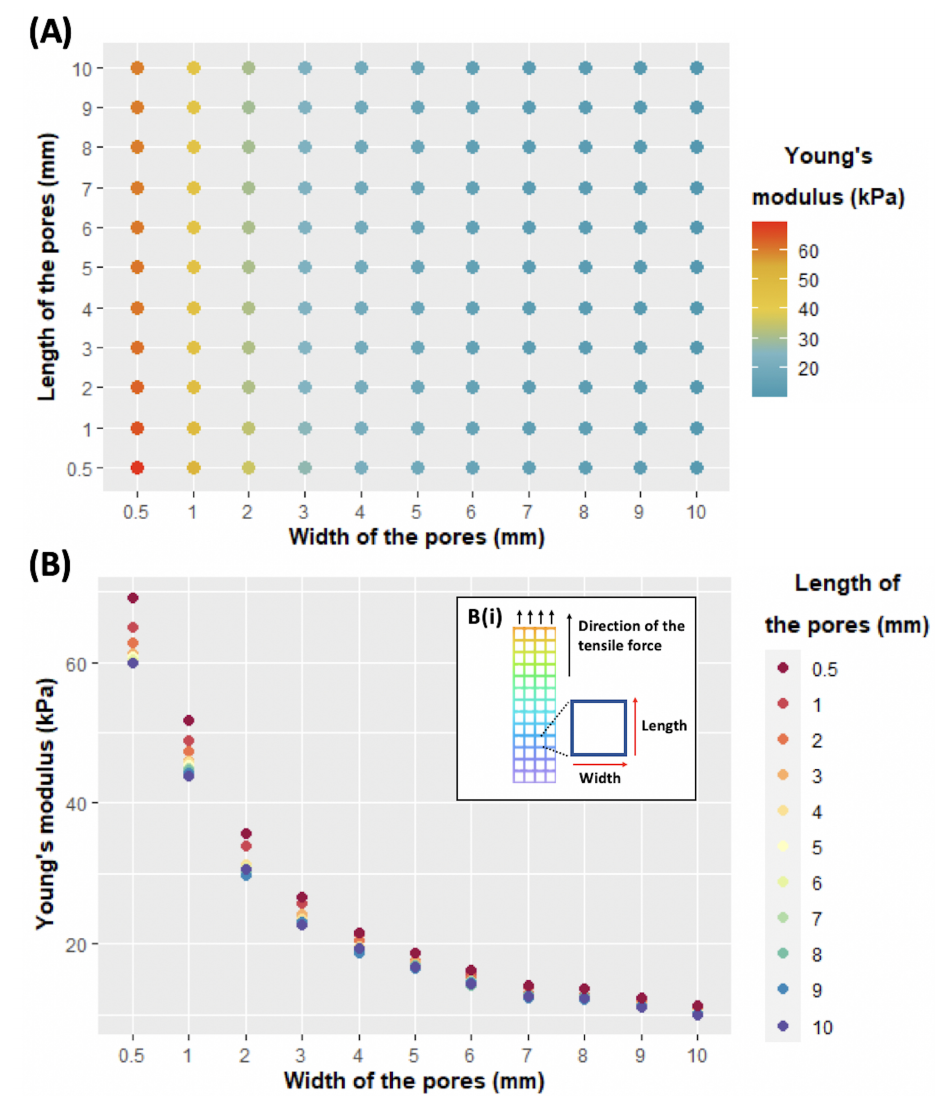
Figure 5. Results of the tensile test in silico of membranes with different widths and lengths of pores. ( A ) Map recapitulating the values of Young’s modulus found for each combination of the pore width and length. ( B ) Alternative representation of the effect of the width and length of internal pores on the Young’s modulus of the membranes and ( Bi ) representation of a modeled membrane clarifying the length and width with respect to the direction of the tensile